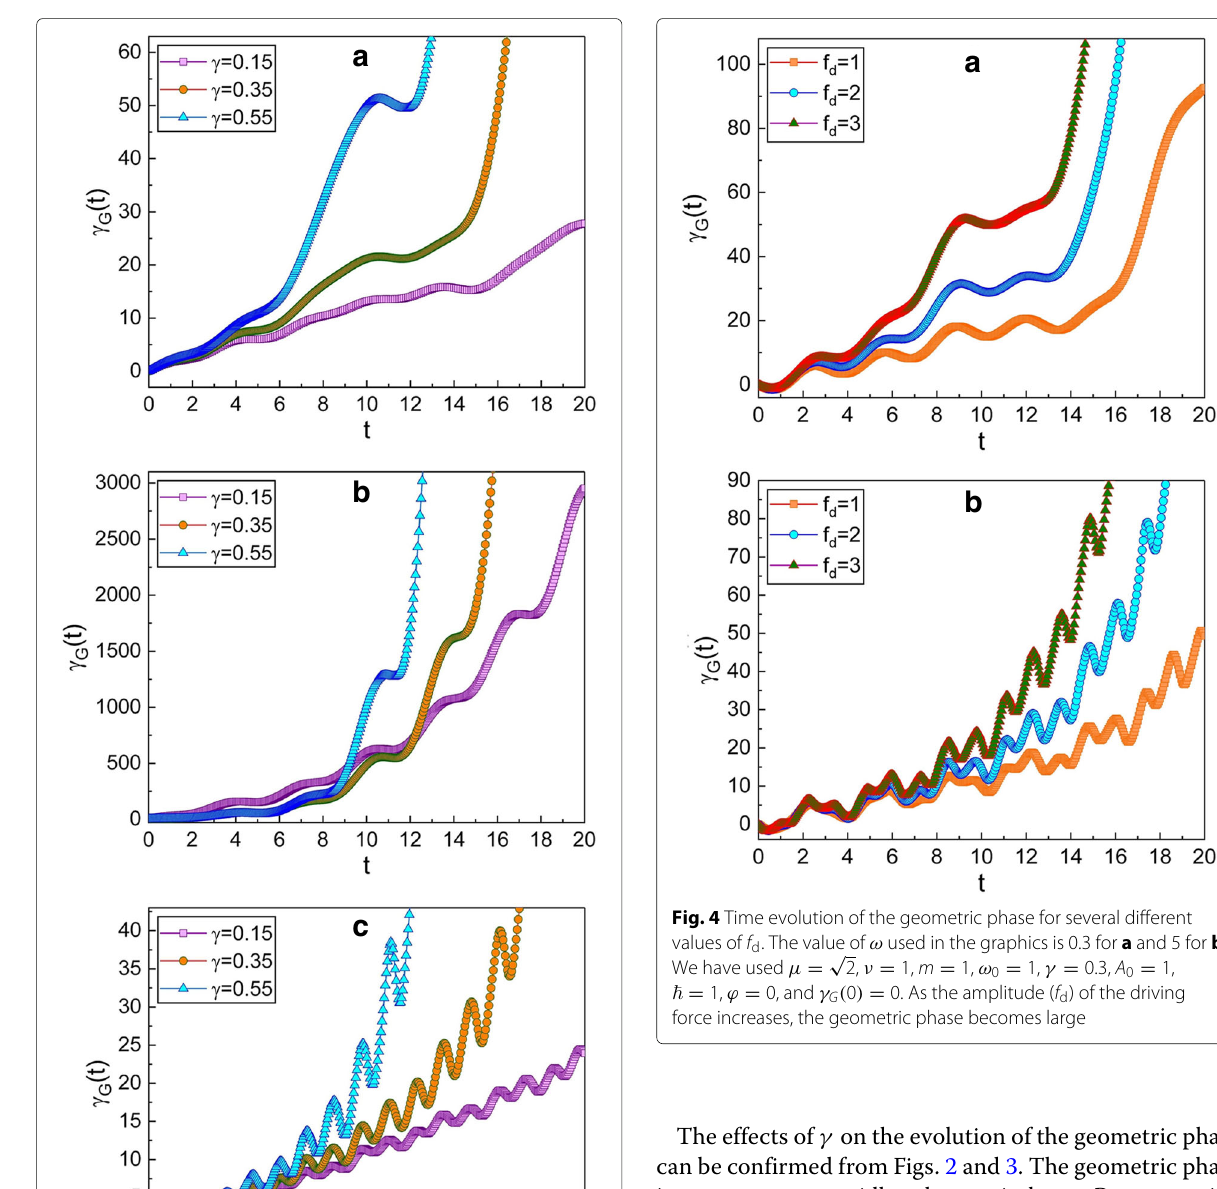
By comparing Figs. 2 and 3 to each other, we can conclude that the geometric phase in the q -squeezed state is nearly the same as that in the p -squeezed state.